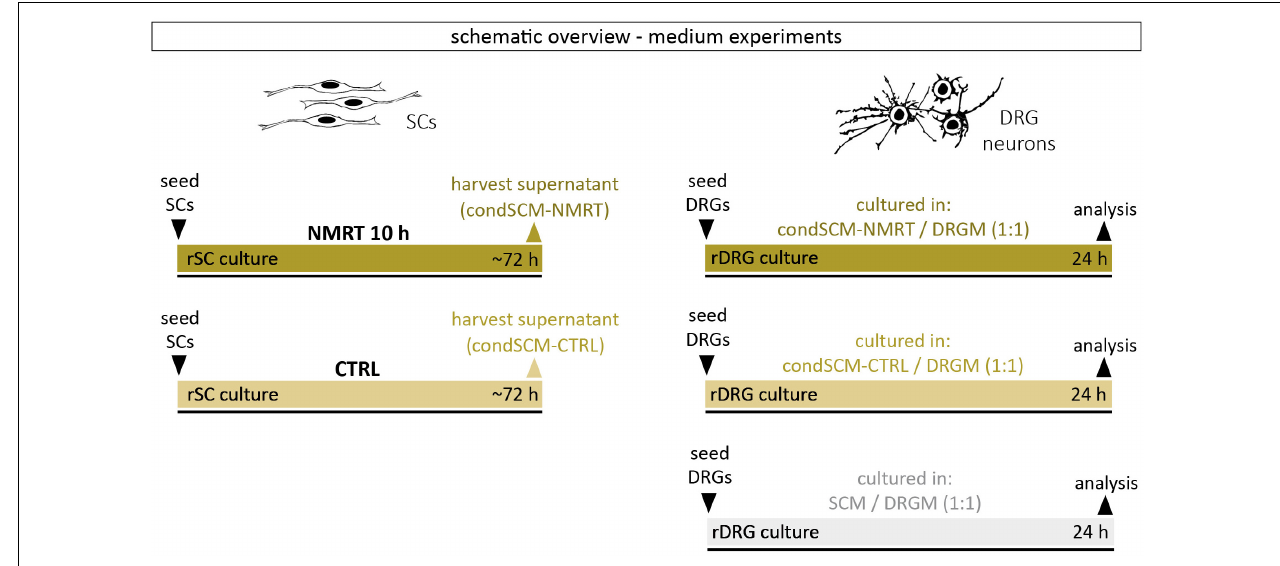
FIGURE 2 | Schematic overview of medium experiments.